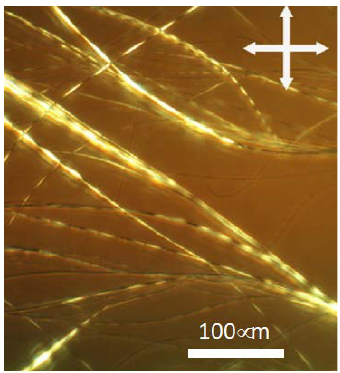
Figure 17. The open mesh of the gel phase of HAT 6 fibres dispersed in an acetonitrile-based solvent, viewed between crossed polars. Note the appearance of a helical gyre structure in the fibres. From Khan et al. [24]. I am indebted to Professor Richard Bushby for drawing my attention to this work.